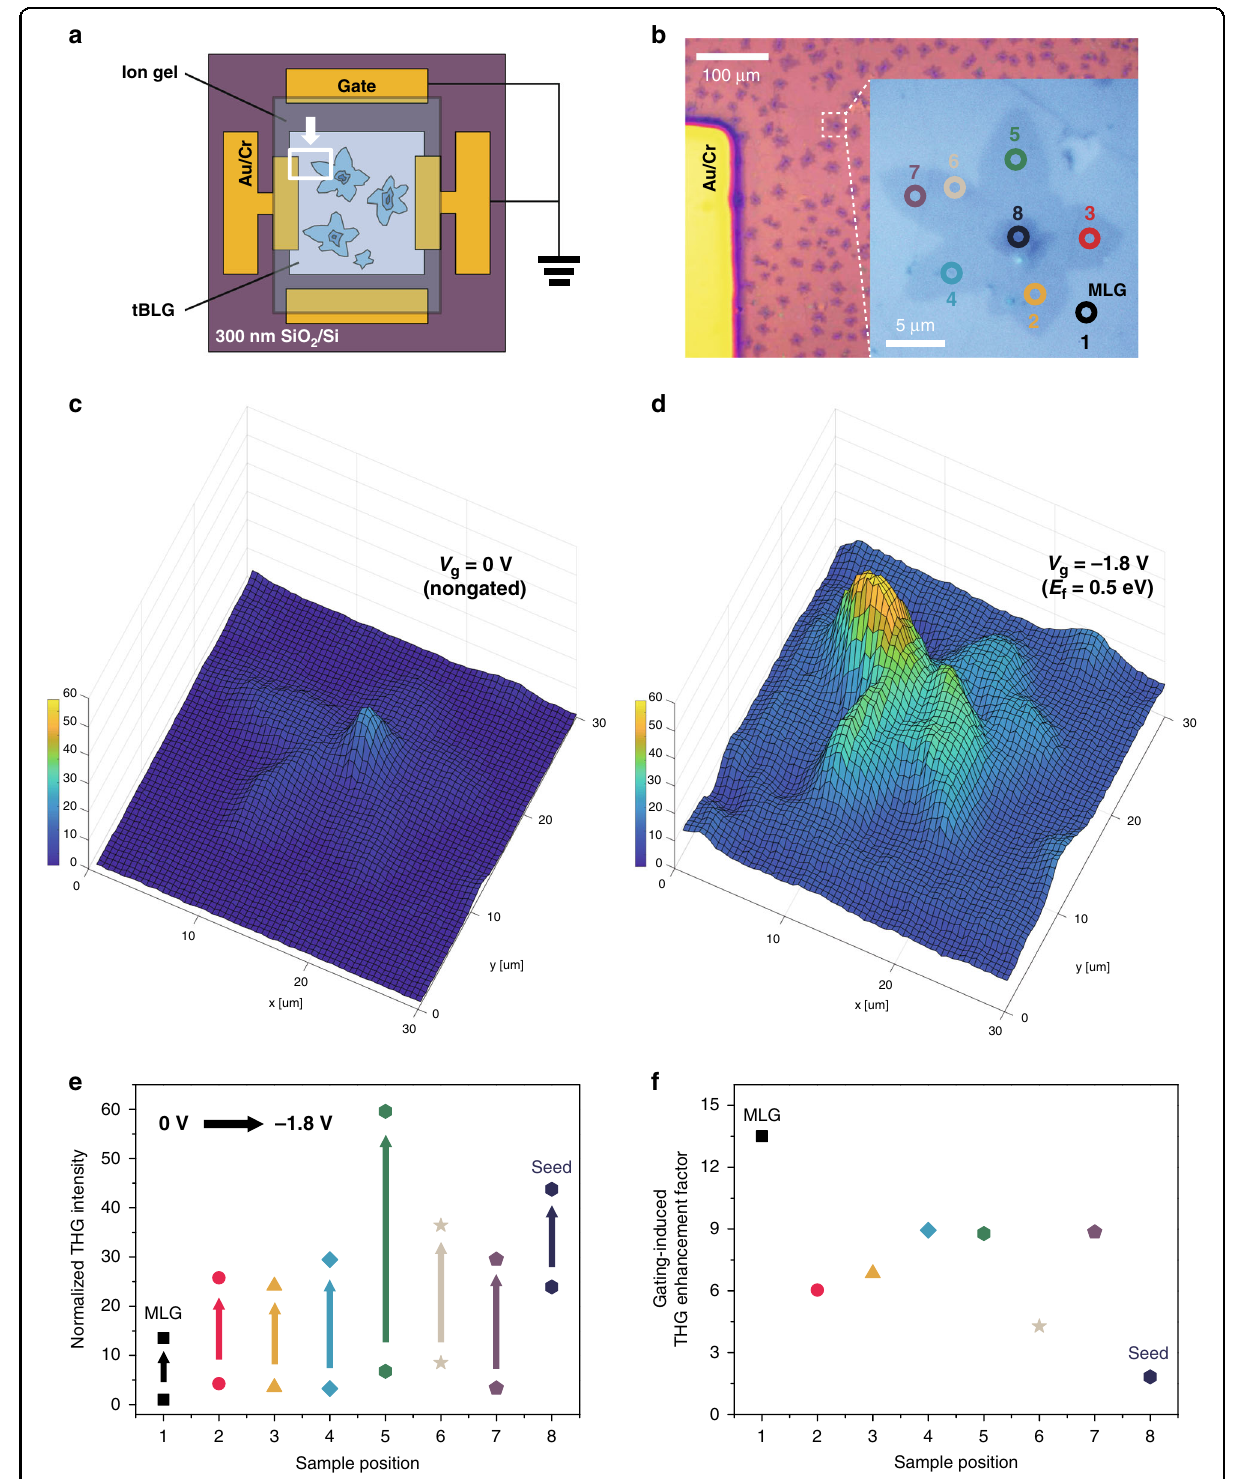
Fig. 4 Third-order optical nonlinearity in tBLG electrically tuned by ion-gel-based top gating. a Schematic diagram of the ion-gel-coated top- gating graphene device. b Microscope image of the graphene area corresponding to the white-coloured rectangle (highlighted with a white arrow) in ( a ). Inset: enlarged microscope image of a selected tBLG region consisting of various twist angles represented with different colour circles, whose Raman spectra are shown in Supplementary Fig. S4b. Measured THG images of the tBLG region (inset in b ) at c V g = 0 V and d V g = – 1.8 V, where the strongest THG occurs from grey-circled tBLG and green-circled tBLG, respectively. e THG intensities normalized by the THG intensity of MLG at V g = 0 V for each graphene position before/after applying a V g of – 1.8 V. f Gating-induced THG enhancement factor; the rate of increased THG intensity at V g = – 1.8 V compared to the THG intensity at V g = 0 V at each graphene position. The number indicates the sample location shown in the inset in ( b